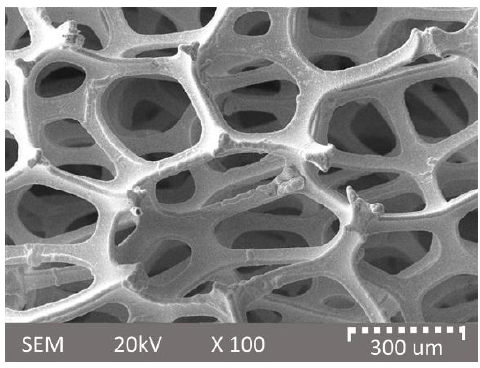
Figure 3. Scanning electron microscopy (SEM) image of metal foam.